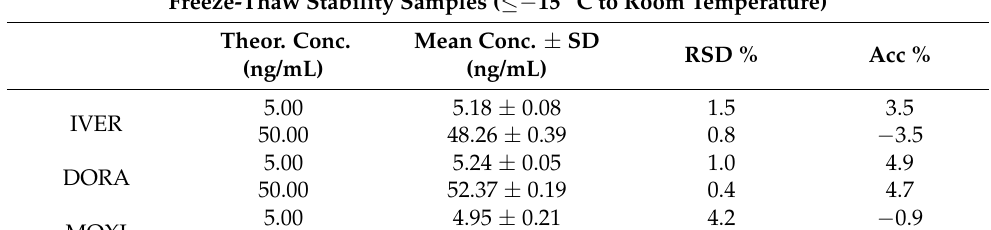
Table 4. Evaluation of the stability of ivermectin (IVER), doramectin (DORA), and moxidectin (MOXI) in bovine plasma during three freeze/thaw cycles and in extracted samples ( n = 3 replicates). Freeze-Thaw Stability Samples ( ≤− 15 ◦ C to Room Temperature) Theor. Conc. Mean Conc. ± SD (ng/mL)